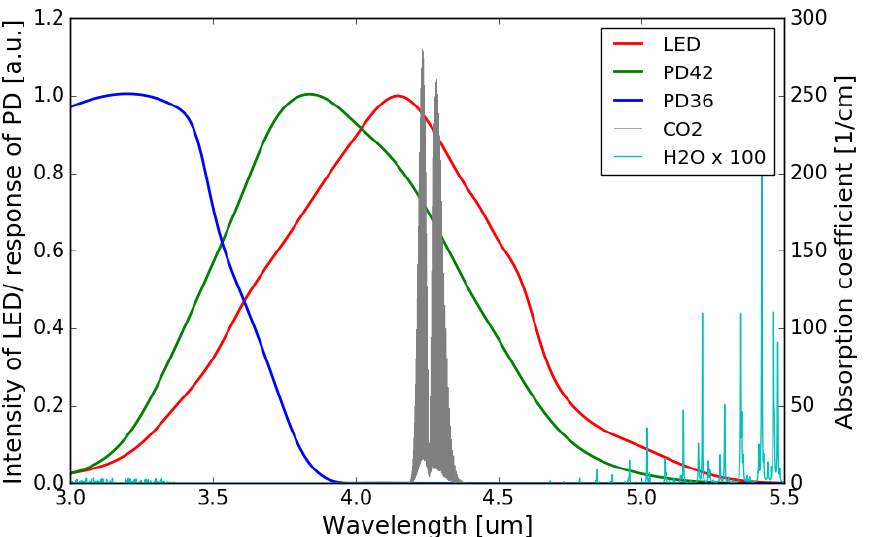
Figure 10. Water vapor and CO 2 absorption spectra in 3.0–5.5 µ m wavelength range (Adapted with permission from ref. [24]. Copyright 2013 Elsevier), together with the emission/responsivity spectra of the LED/photodiodes. The amplitude of the water vapor absorption spectrum is magnified by a factor of